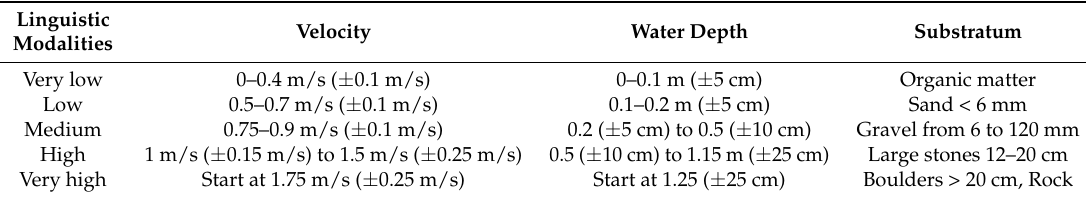
Table 2. List of the variables used as input for the habitat suitability model.